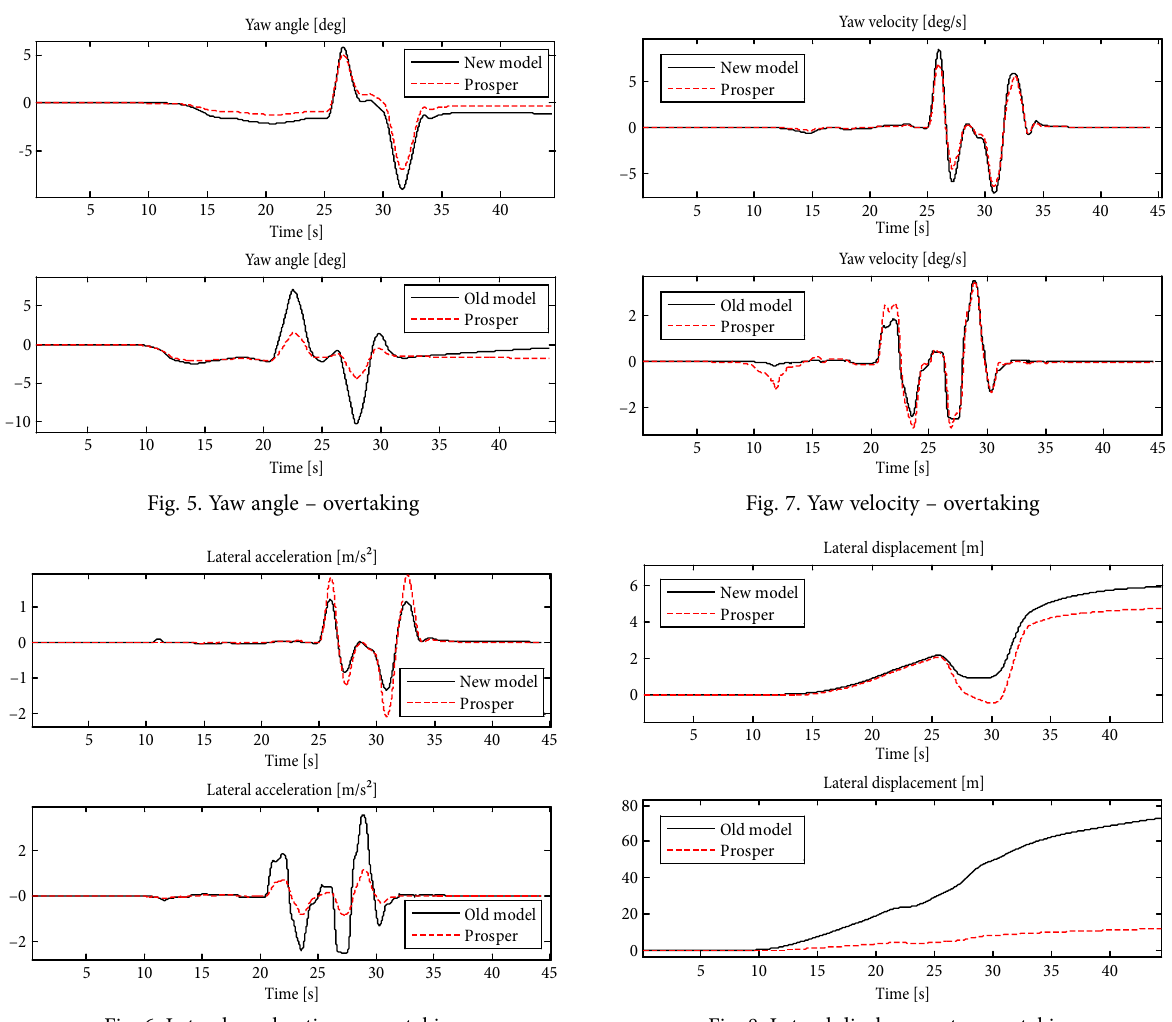
Fig. 6. Lateral acceleration – overtaking